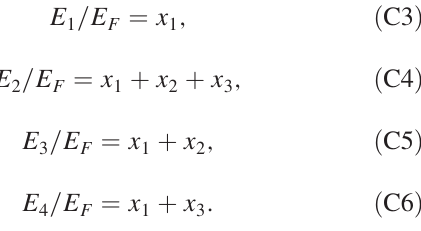
ffiffiffiffiffiffiffiffiffiffiffiffiffiffiffiffiffi p 8 E = π m F